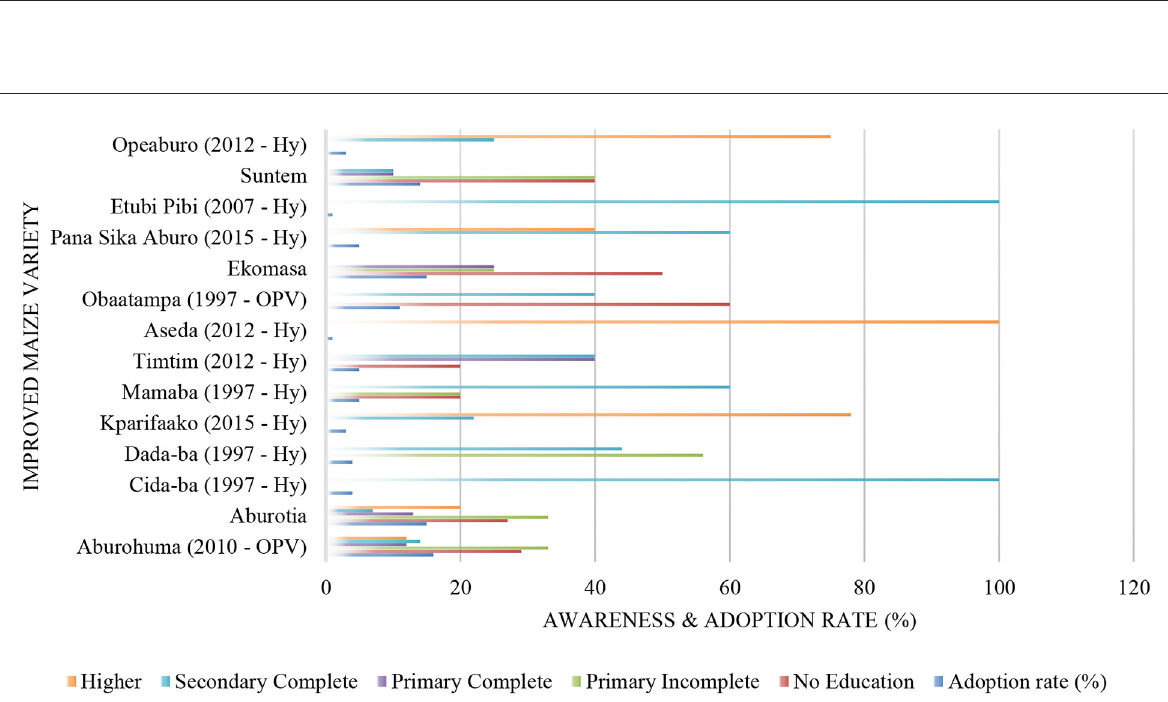
FIGURE4 Distribution showing improved maize variety and adoption rate per level of education. Hy, Hybrid; OPV, Open Pollinated Varieties. This figure compares the overall adoption rate with the adoption rate of respondents who belongs to a particular education level category. Author,